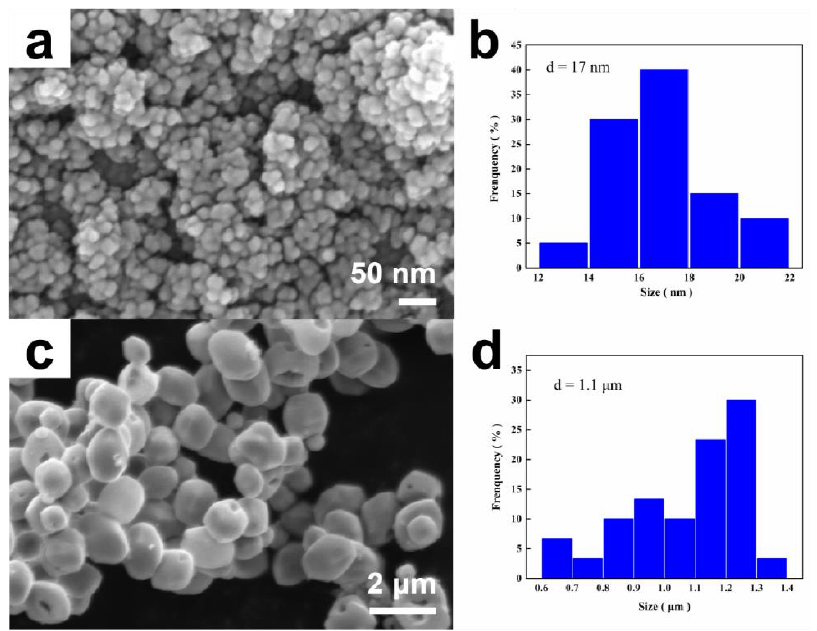
Figure 2. ( a ) SEM of RT and ( b ) histogram of the particle size distribution; ( c ) SEM of α -Fe 2 O 3 and ( d ) histogram of the particle size distribution.